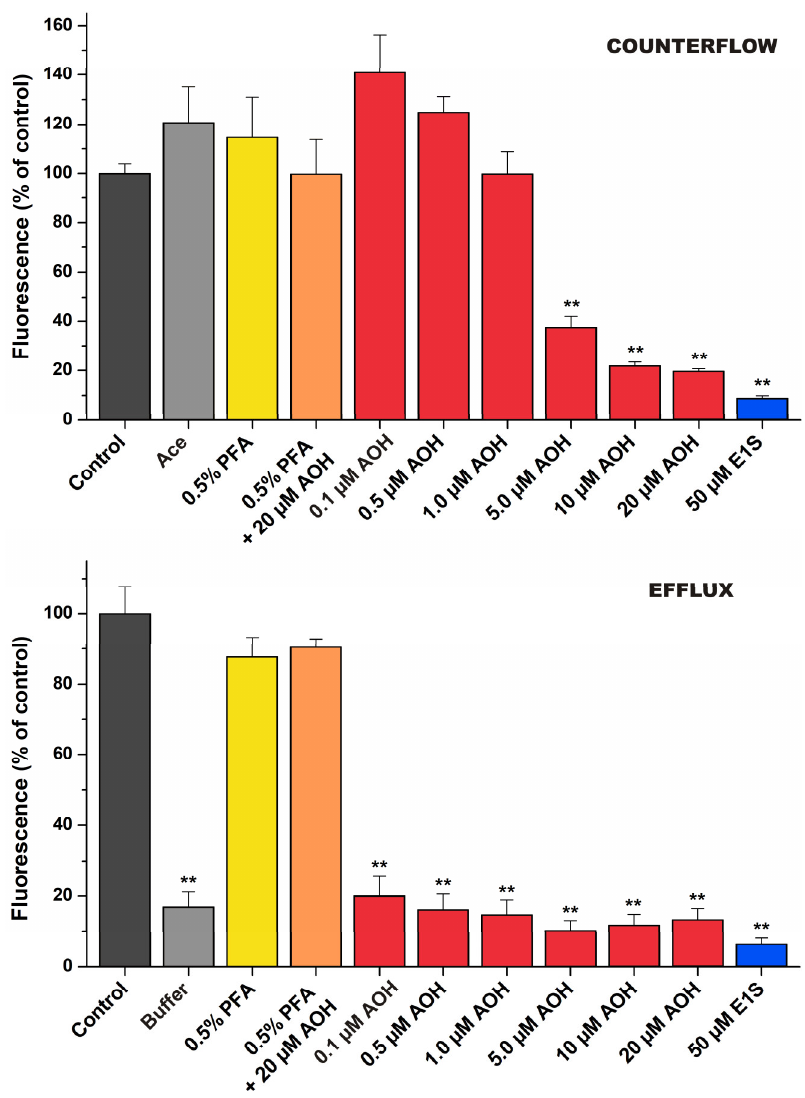
Figure 5. Effects of AOH on dye transport in CCF ( top ) and efflux ( bottom ) assays (see experimental details in Section 2.8; n = 3; ** p < 0.01).